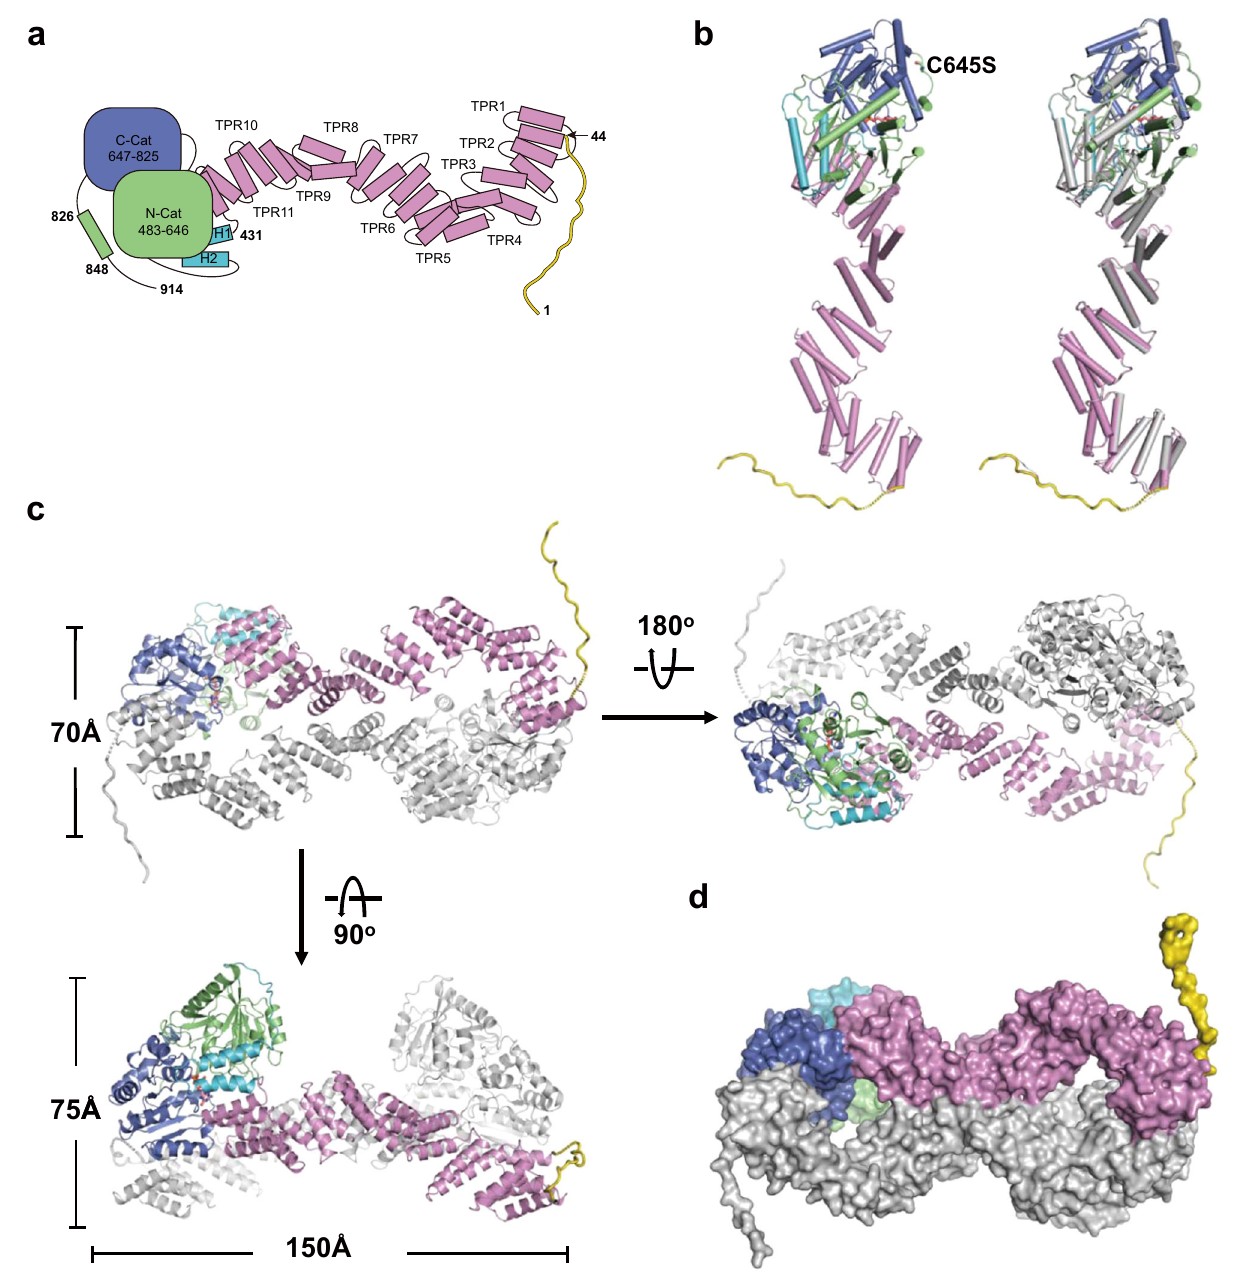
Fig. 1 | Structure of SPY/GDP complex. a Schematic diagram of Arabidopsis SPY. TheN-terminalloop,theTPRdomain,theconnectorregion,theN-Catlobeandthe C-Cat lobe are colored in yellow, pink, turquoise, green and purple, respectively. b Left panel is the structural overview of the SPY/GDP complex in cartoon repre- sentation. The C645S and GDP are shown in ball-and-stick model and colored in